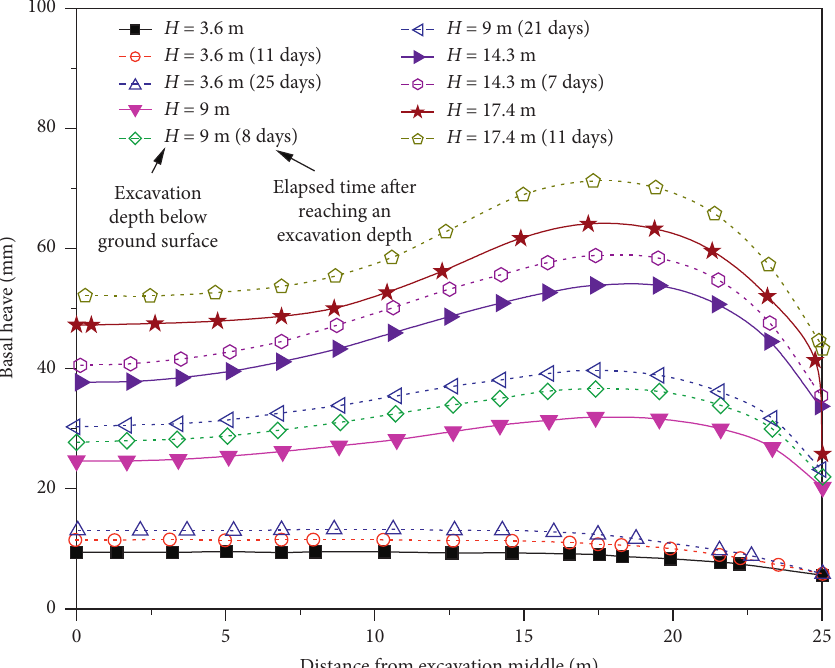
Figure 8: FEM-calculated basal heaves for various excavation depths and elapsed times, modified from